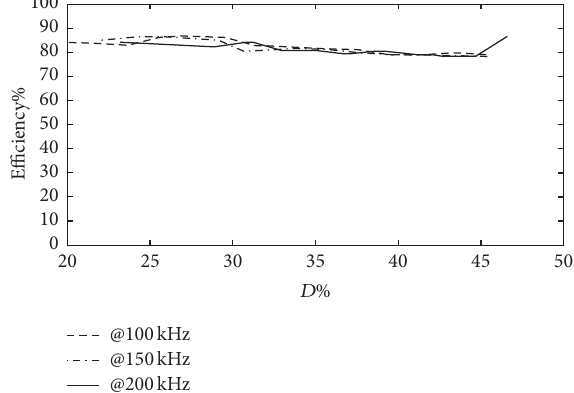
Figure 11: The efficiency versus the duty cycle at different frequen-